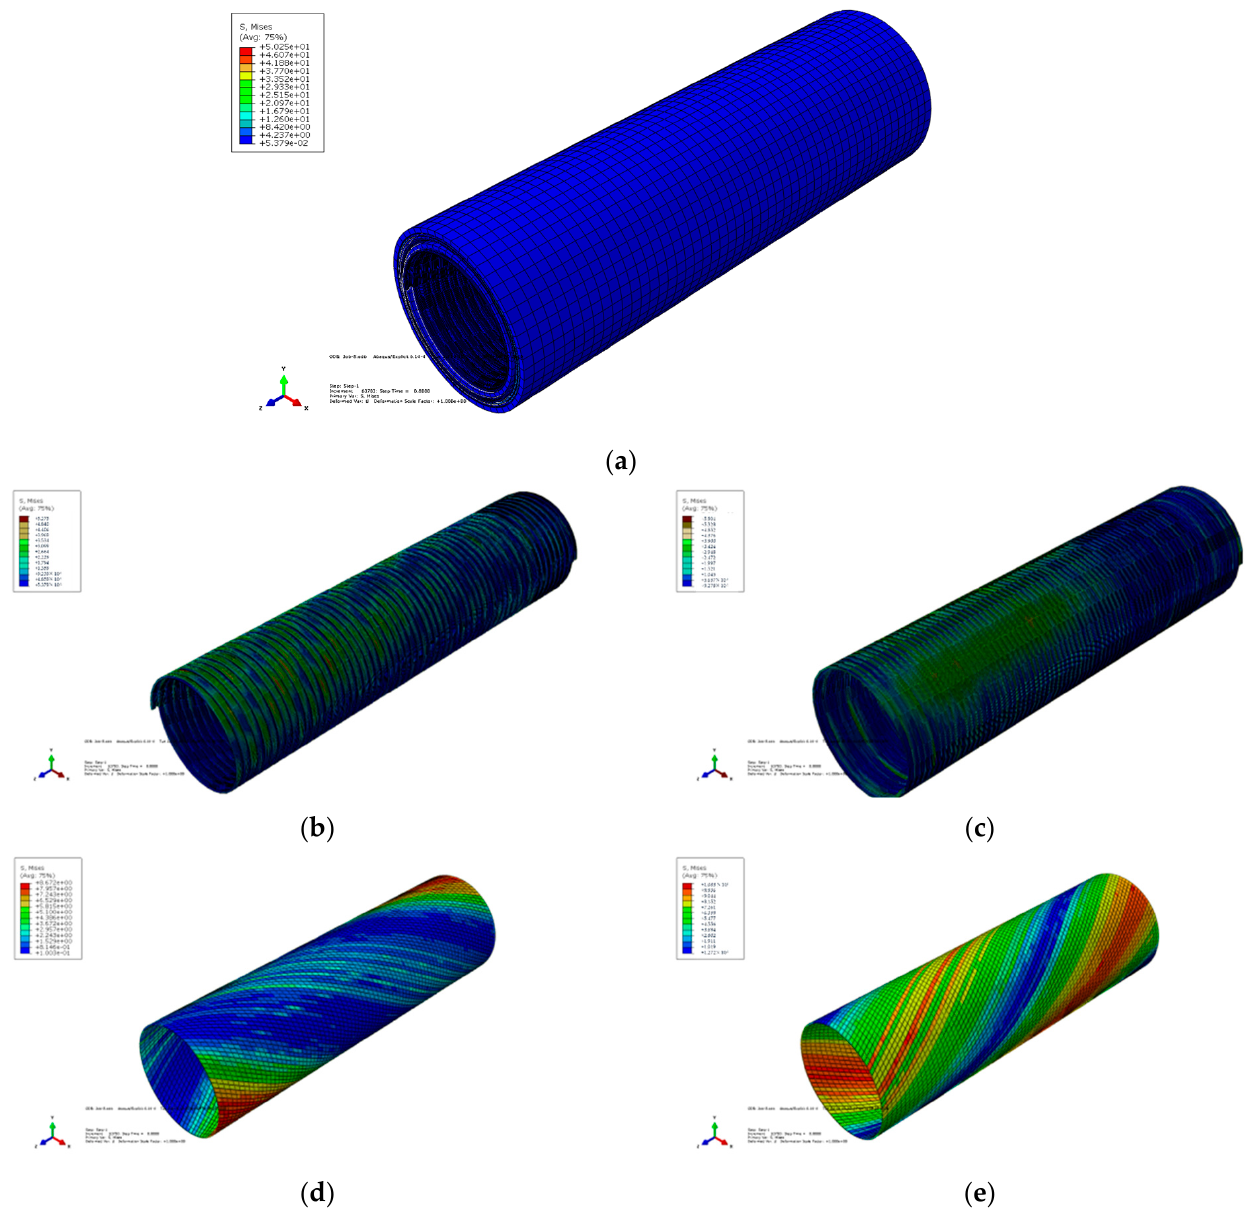
Figure 8. A stress nephogram under bending moment. ( a ) The riser; ( b ) Skeleton layer; ( c ) Compressive armor layer; ( d ) Internal tensile armor layer; ( e ) External tensile armor layer. The structural stress of each metal layer under torsion is as Figure 9 .